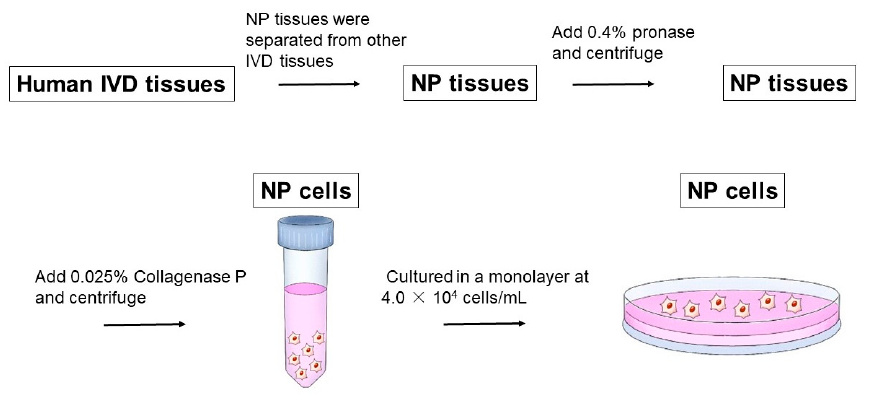
Figure 11. Isolation of the human nucleus pulposus (NP)